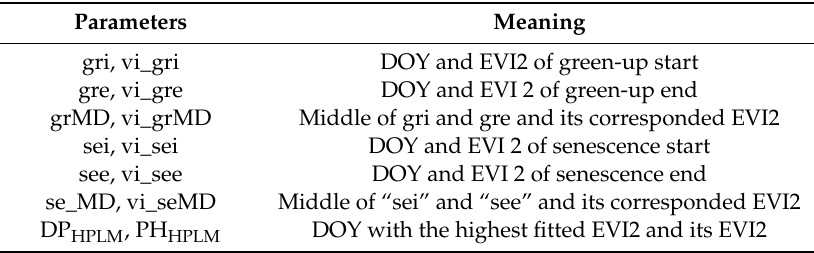
Table 2. Variables derived from the Hybrid Piecewise Logistic